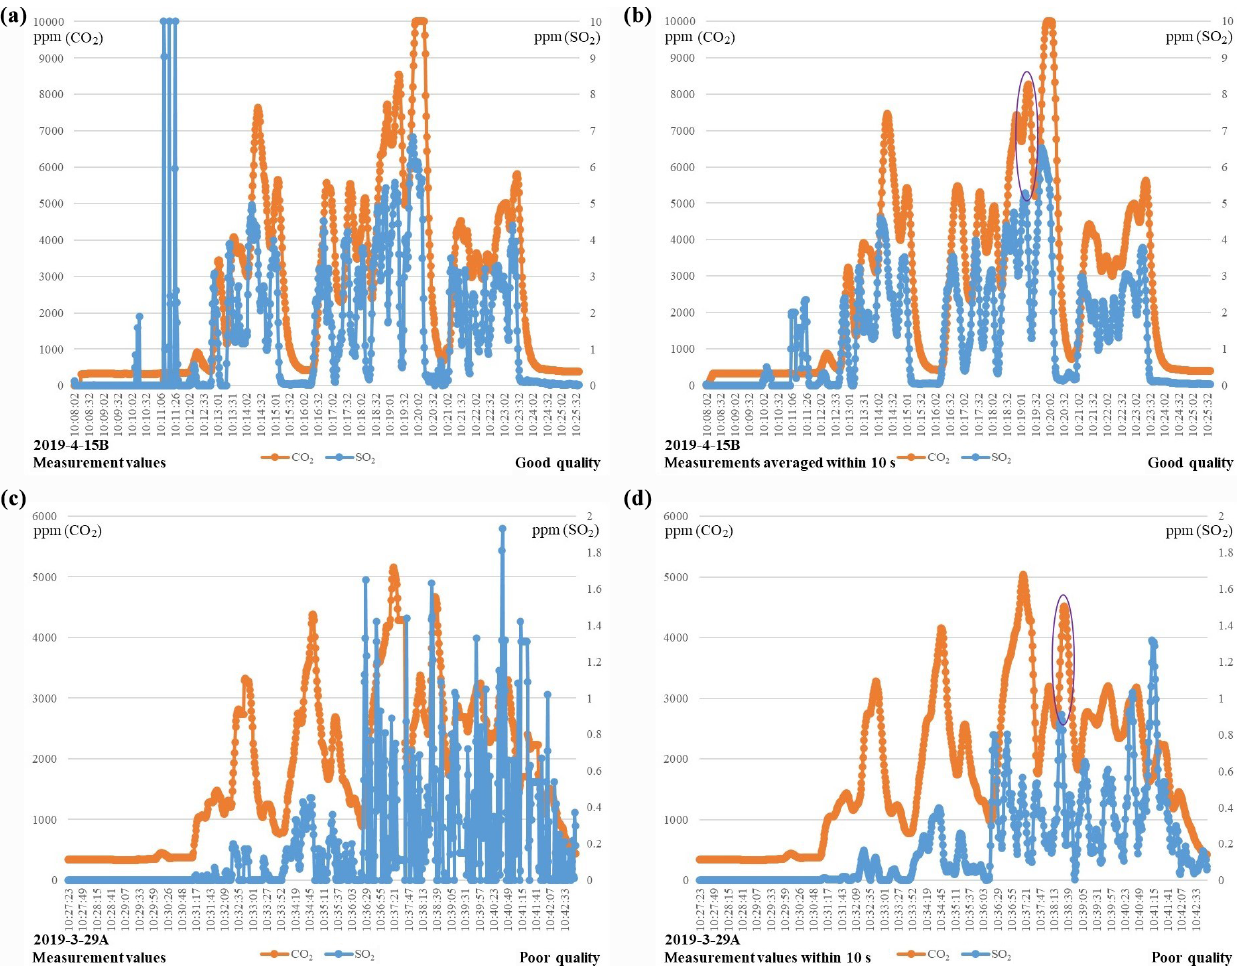
Figure 5. Typical measurement data for SO 2 and CO 2 concentrations, and their corresponding average values within 10s. (a, b) Good-quality data from plume 2019-4-15B. (c, d) Poor-quality data from plume 2019-3-29A. There are some errors in the measurements from 10:11:06 to 10:12:02LT in panel (a) , which may have been caused by sensor uncertainty. These data were excluded and did not affect the calculation results. After selection, the peak values are circled in